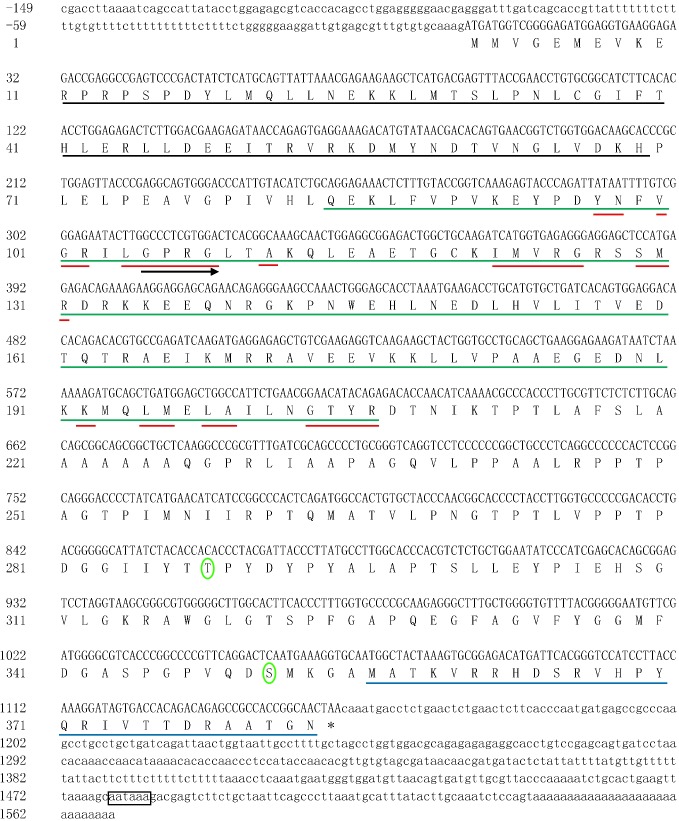
The nucleotide sequence of the qkia cDNA in blunt snout bream, and the deduced amino acid sequence. Uppercase letters indicate the translated region, whereas lowercase letters represent the untranslated region. Blank line indicates the STAR_dimer, green line reveals the SF1_like-KH, red line suggests the potential RNA-binding sites, and blue line represents the Quaking_NLS. Right arrow indicates the G-X-X-G motif. An asterisk suggests the termination codon. The phosphorylated sites are circled and the polyadenylation signal is boxed. The nucleotide sequence was submitted to NCBI GenBank, accession number: KY_444733.